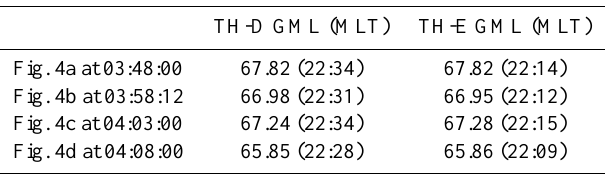
Table 1. Footprints of TH-D and TH-E during the second event (E-2) shown in Fig. 4.